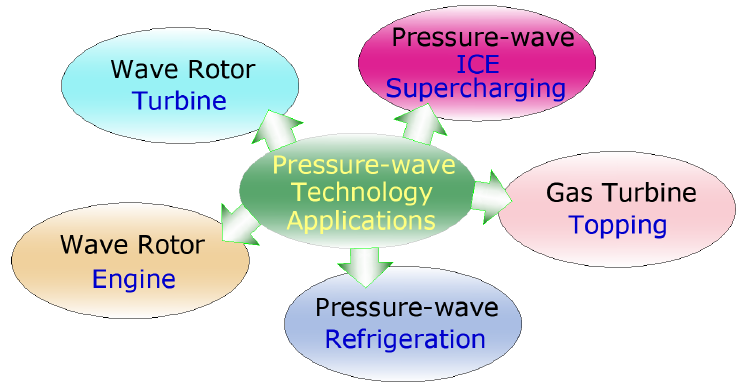
Figure 1. Wave rotor applications.